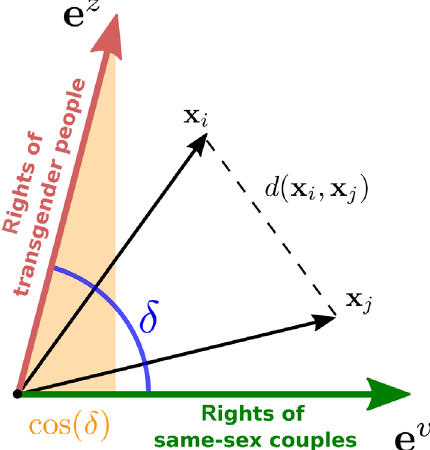
FIG. 1. Illustration of two nonorthogonal topics as a basis for the topic space T . For T ¼ 2 , the nonorthogonal, normalized basis is uniquely defined by the angle δ . Geometrically, cos ð δ Þ quantifies the overlap between basis vectors, interpreted as a topical overlap, here the rights of same-sex couples ( e ð u Þ ) and transgender people ( e ð v Þ ). The opinion distance between two agents i and j , d ð x i ; x j Þ , is computed by the scalar product defined in Eq.